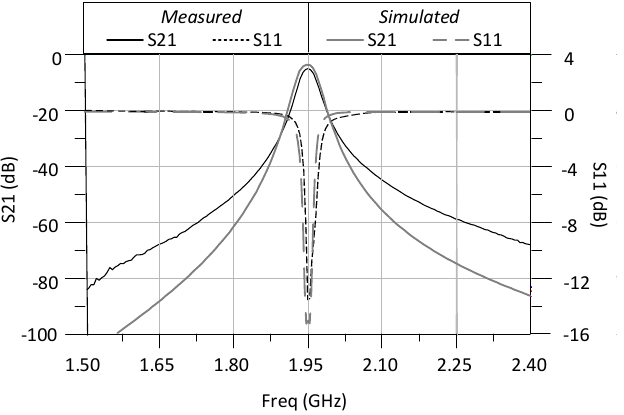
Figure 11. Comparison between simulated and measured S-parameters at center frequency.